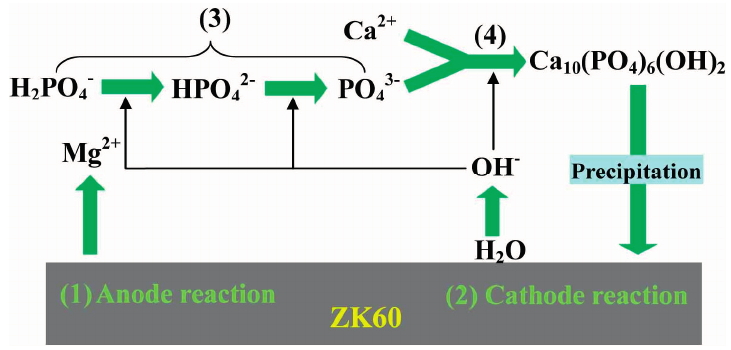
Figure 2. Schematic illustration of the reaction mechanism of calcium phosphate coatings on ZK60 substrate. (1) Anode reaction; (2) Cathode reaction; (3) Transformation of H 2 PO 4 − to PO 43 − ; and (4) HA phase producing